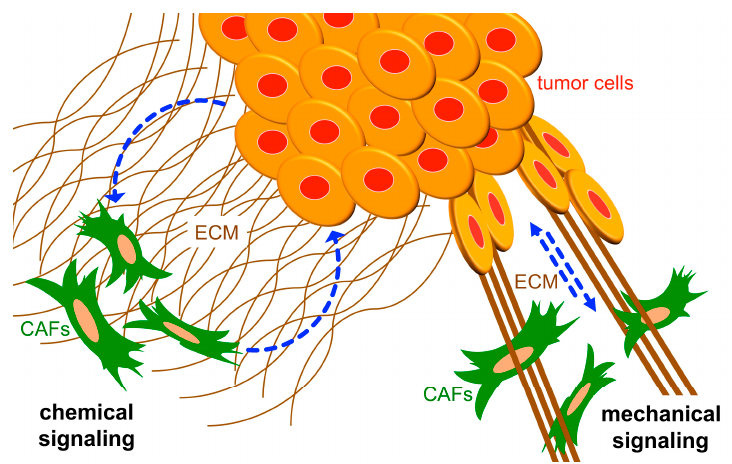
Figure 1. Integrins regulate intercellular communication in the tumor microenvironment (TME). ECM receptors (integrins) on the cell surface (not depicted in the illustration) regulate paracrine signaling between tumor cells and stromal CAFs. Paracrine signaling can be mediated by secreted factors (i.e., chemical signaling, depicted on the left) or changes in matrix stiffness (i.e., mechanical signaling, depicted on the right). ECM: extracellular matrix; CAFs: cancer-associated fibroblasts.